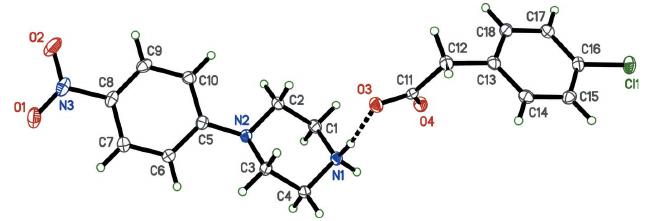
Figure 3 The molecular structure (50% displacement ellipsoids) of III . Hydrogen atoms are shown as arbitrary circles. The dashed line indicates a hydrogen bond.